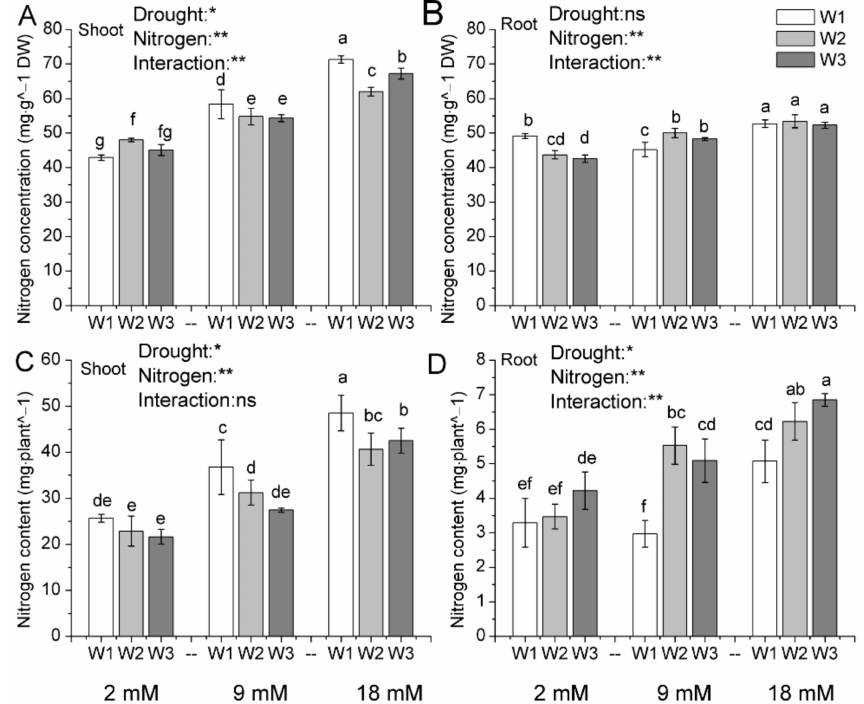
Figure 3. Nitrogen concentration ( A , B ) in shoots and roots, nitrogen content ( C , D ) in shoots and roots of pakchoi at the end of the experiment. W1: 0 g · L − 1 PEG 6000, blank; W2: 60 g · L − 1 PEG 6000, mild drought stress; W3: 120 g · L − 1 PEG 6000, moderate drought. Bars with the different letters indicate significant difference ( p < 0.05). Error bars represent the standard deviation. p -values of the ANOVAs of drought, nitrogen supply, and their interaction are indicated. ns, not significant. * p < 0.05. ** p <